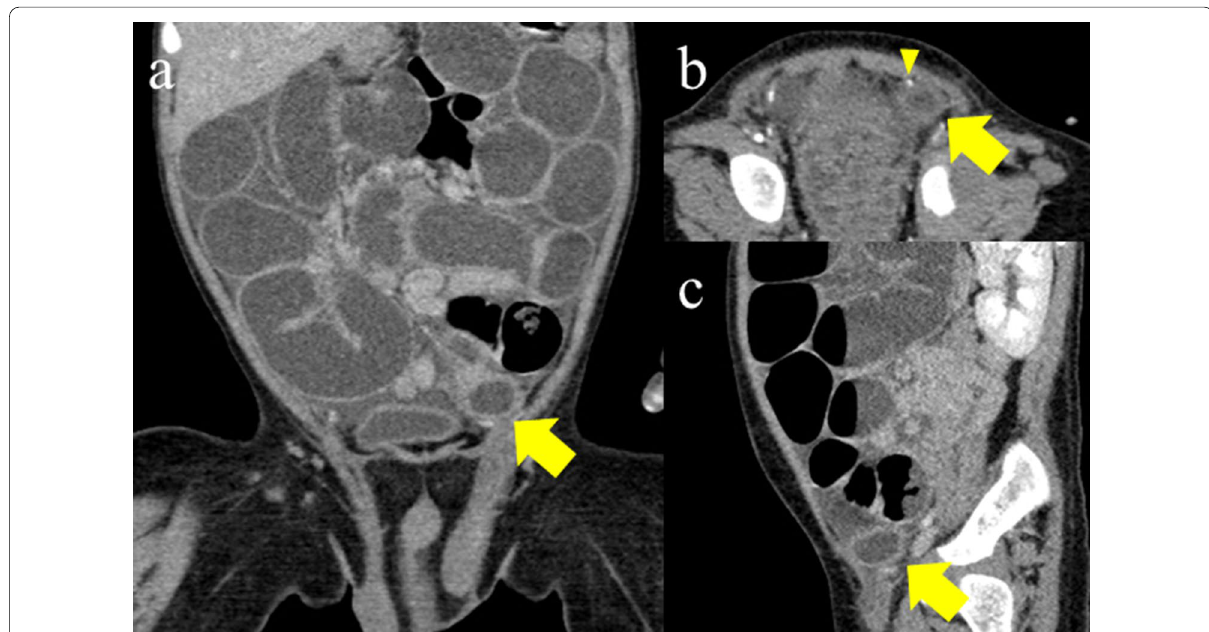
Fig. 3 Enhanced CT findings. Closed loop in the left groin (yellow arrow). a Coronal section. b Axial section and inferior gastric artery (yellow arrowhead). c Sagittal